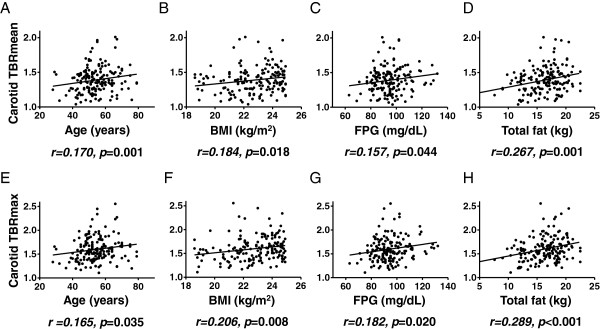
Correlation between carotid TBR, various clinical factors, and body fat mass. A correlation graph was drawn between the carotid (A-D) mean or (E-H) maximum TBR and age, BMI, fasting plasma glucose levels, and total body fat. The degree of relationship between putative CVD risk factors and TBRmean or TBRmax was expressed using Pearson’s correlation coefficient (r). TBR, target-to-background ratio; BMI, body mass index; FPG, fasting plasma glucose. p < 0.05 was regarded as statistically significant.